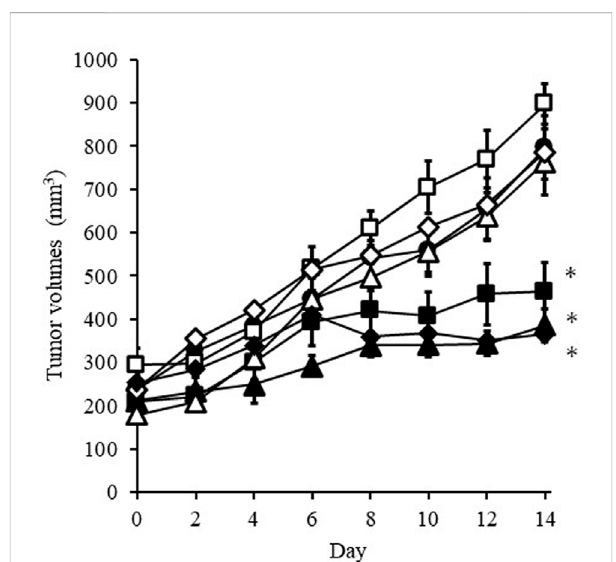
FIGURE 3 Change in tumor volume after administration of DXR solution or (cid:129) PBS every 2 days. Symbols; : i.v. injection of PBS, ◇ : i.v . injection of DXR at a dose of 20 μ g, ■ : i.t. administration of DXR with a syringe at a dose of 20 μ g, △ : iadministration of PBS with an EO pump, □ : i.t. administration of PBS with a syringe, ▲ : i.t. administration of DXR with an EO pump at a dose of 20 μ g, ◆ : i.v. injection of DXR at a dose of 100 µg. Each point shows the mean ± S.E. ( n = 5). * Signi fi cant difference( p < 0.05)wasobservedcomparedwith i.v.